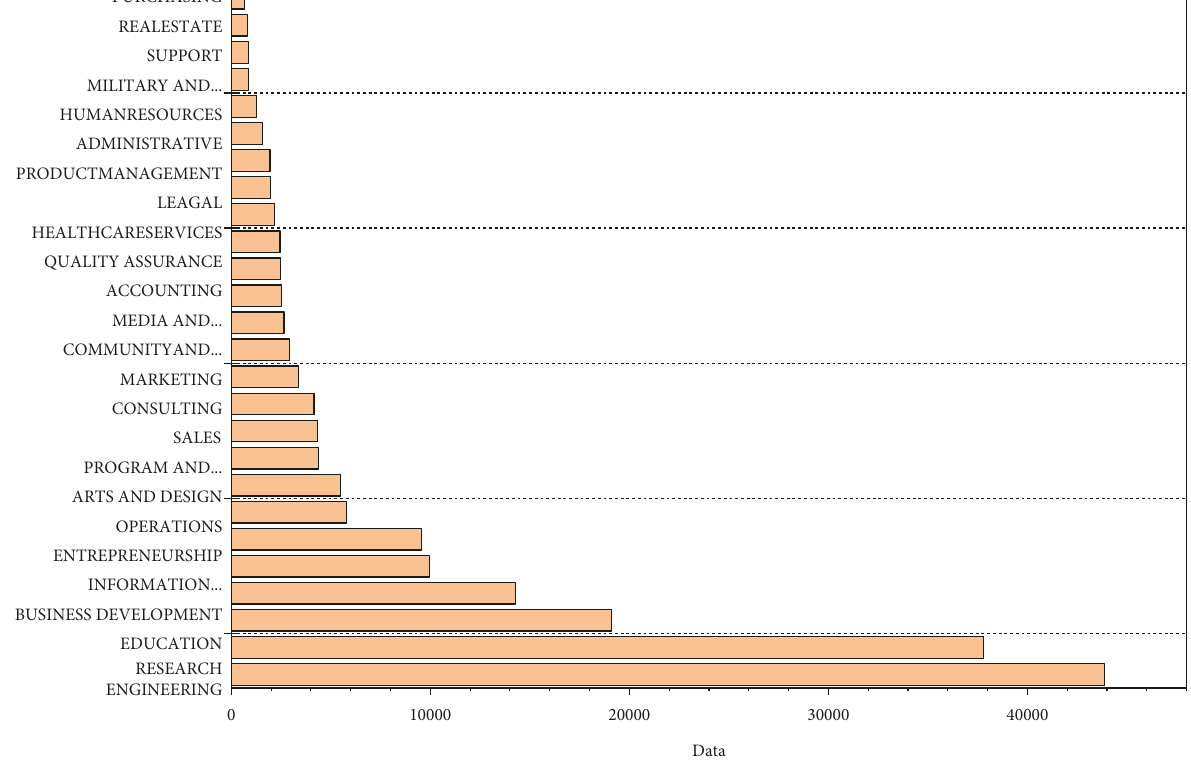
Figure 1: High-level talent data.